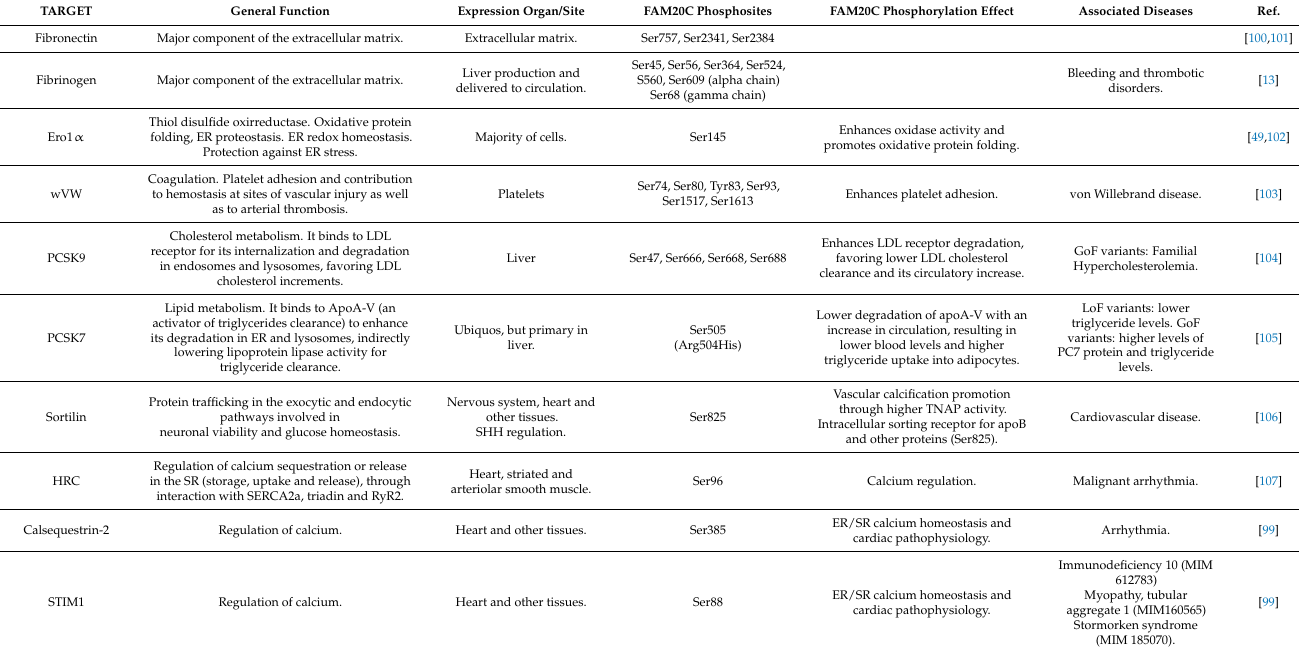
Table 1. Novel FAM20C targets involved in different functions.